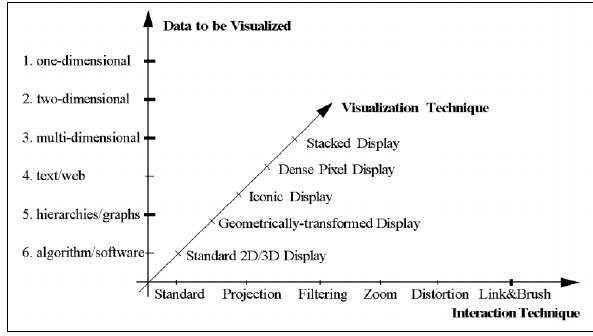
Figure 1. Classification of Data Visualization Techniques by Keim, 2002.